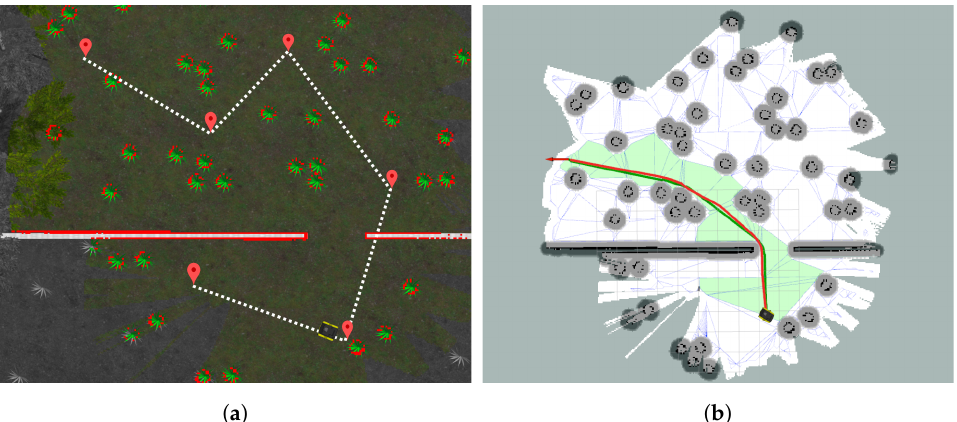
Figure 9. Illustration of the exploration strategy using a top-down figure of the environment and the corresponding path planning results (reference paths obtained from the Navigation with Polytopes toolbox and from the standard Navfn planner of ROS plotted in red and green lines, respectively). ( a ) Exploration program window; ( b ) path planning results after the